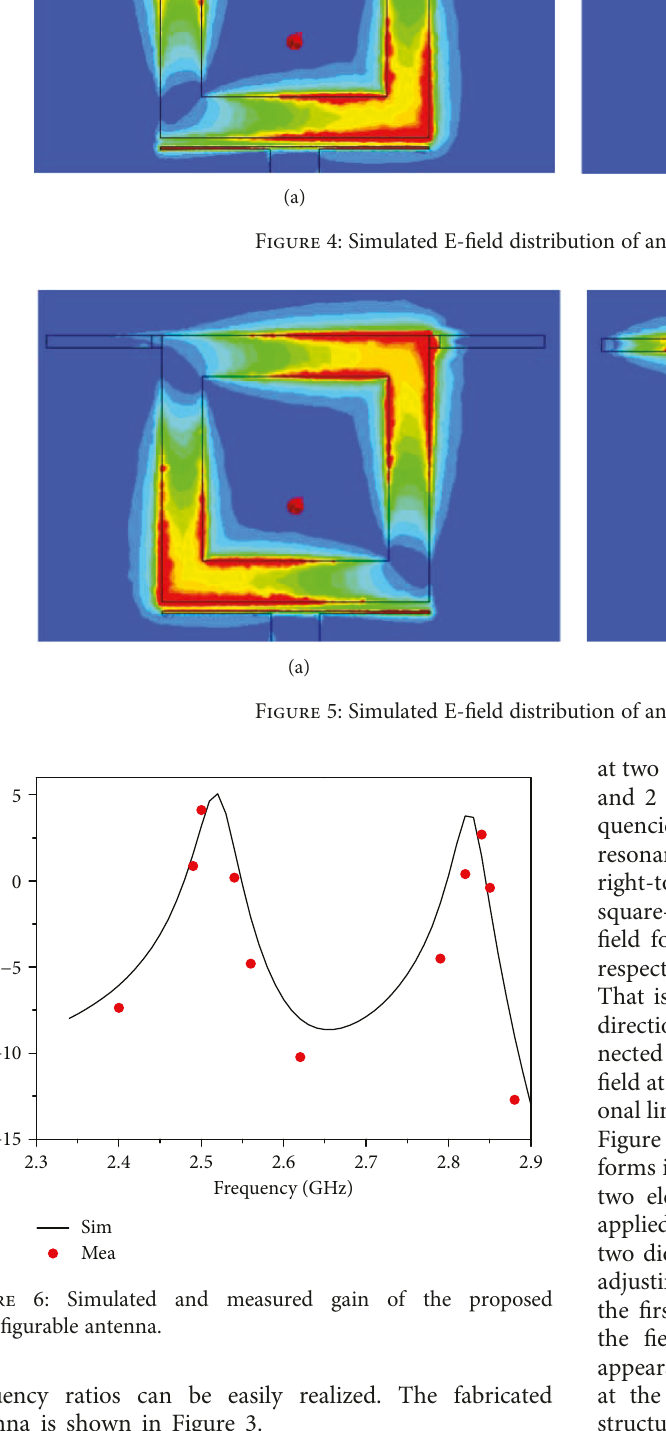
Figure 6: Simulated and measured gain of the proposed recon fi gurable